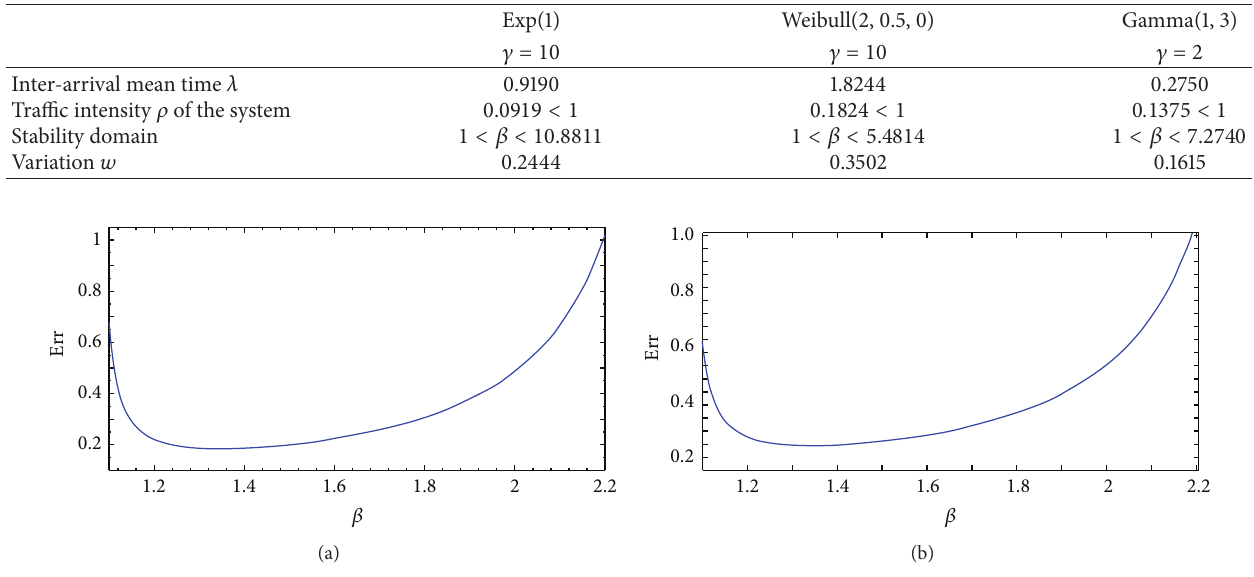
Figure 2: Error Err in function of 𝛽 (a) with the theoretical density 𝑔(𝑥) and (b) with Gamma kernel estimate ̂𝑔 𝑏 (𝑥) .